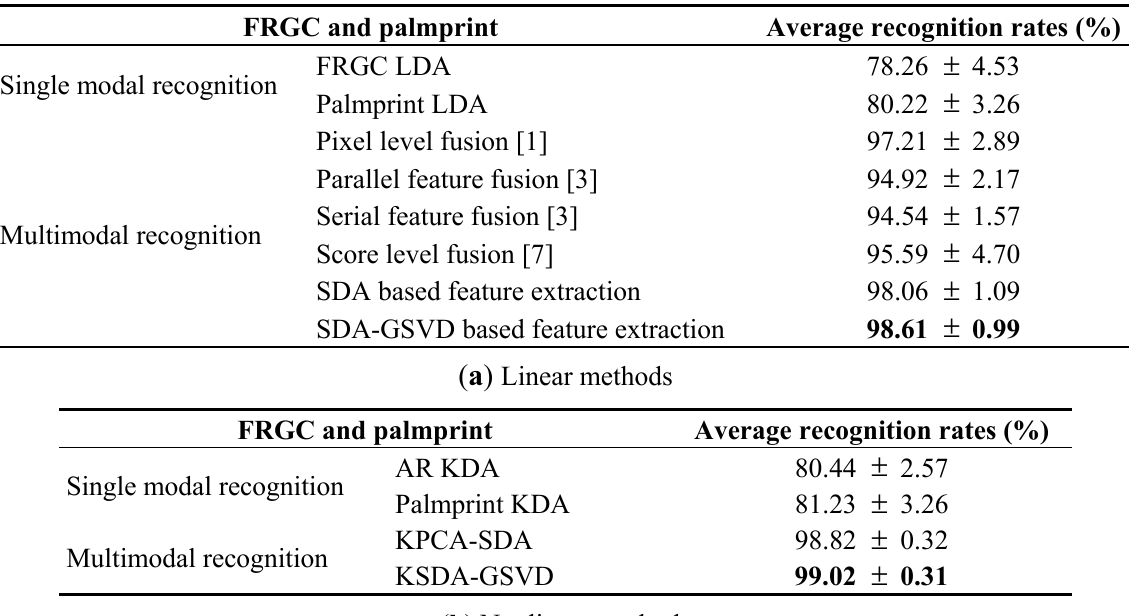
Table 2. Average recognition rates of compared methods on FRGC face and PolyU palmprint